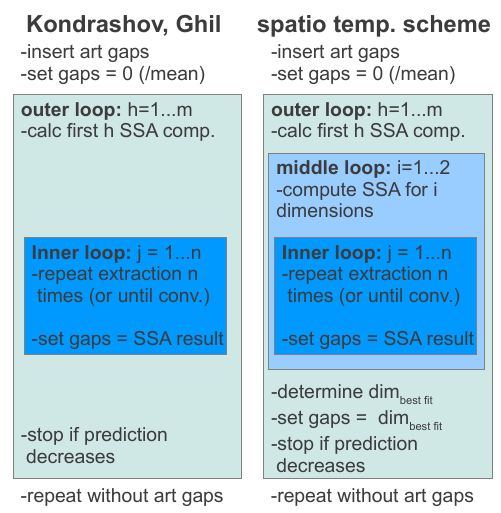
Fig. 1. Comparison between the concepts of the Kondrashov and Ghil (2006) gap filling scheme and the proposed spatiotemporal